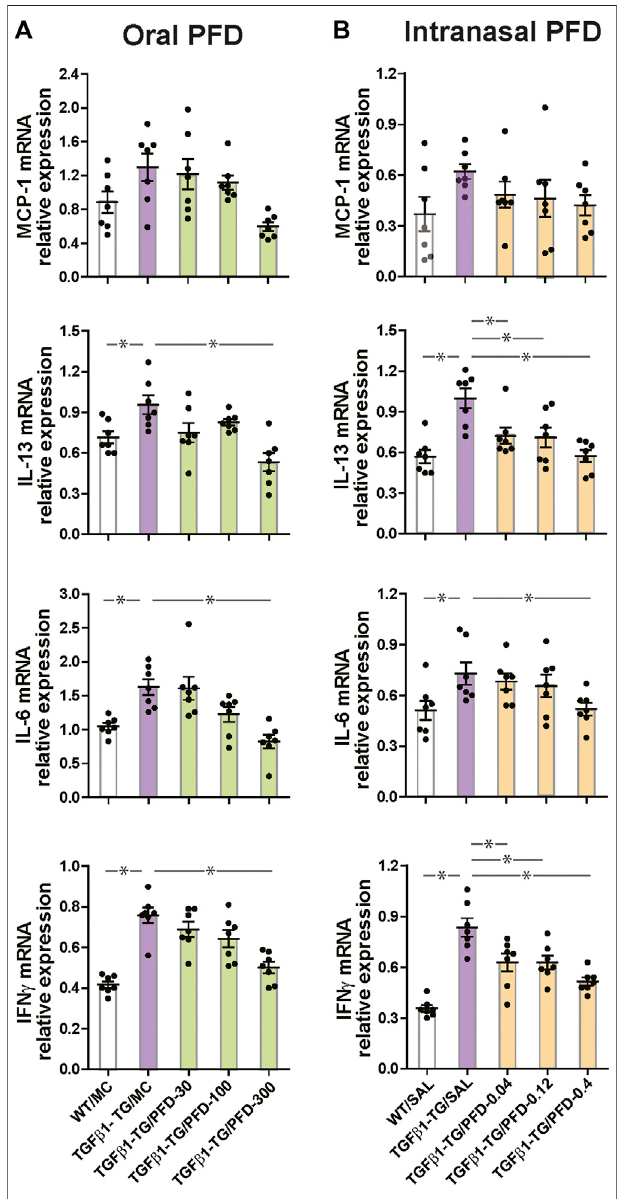
FIGURE 3 | Signi fi cant reduction in the relative mRNA expression of in fl ammatory cytokines in the lungs from mice treated with pirfenidone (PFD) by oral or intranasal administration compared to controls. Human transforming growth factor (TGF) β 1 transgenic (TG) mice were allocated in groups treated with PFD by oral ( A ; n (cid:2) 7) or intranasal ( B ; n (cid:2) 7) administration and ingroupstreated withthevehicle saline (SAL; n (cid:2) 7)or with the vehicle methylcellulose (MC; n (cid:2) 7) twice aday for 21 days and once aday on day 22 before euthanasia. Wild type (WT; n (cid:2) 7) mice treated with saline or MC were used as negative controls. The relative mRNA expression of monocyte chemoattractant protein-1 (MCP-1), interleukin (IL)-13, IL-6, and interferon γ (IFN γ )wasevaluatedbyRT-PCRasdescribedundermaterialsand methods. Data are expressed as the mean ± S.E.M. Statistical analysis by Student ’ s t -test and ANOVA with Dunnett ’ s post hoc test. * p <